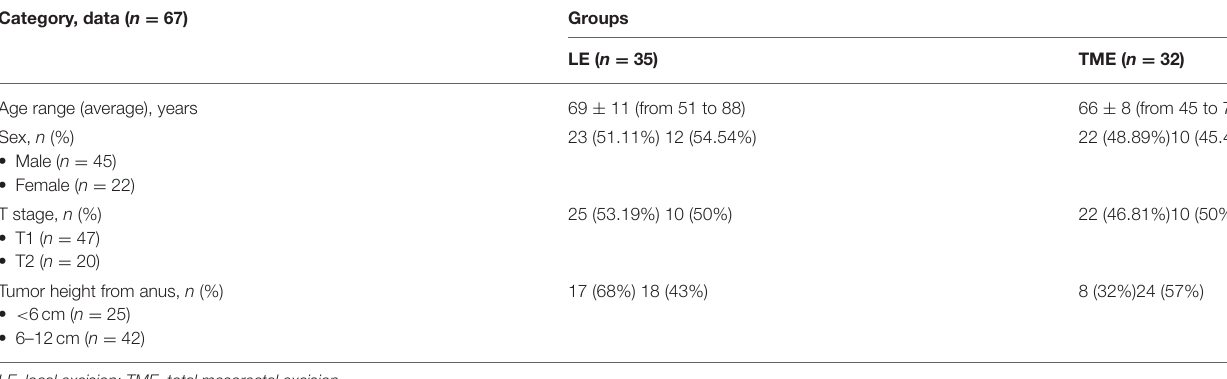
TABLE 1 | Patient and tumor characteristics of both the study groups. Category, data ( n = 67)